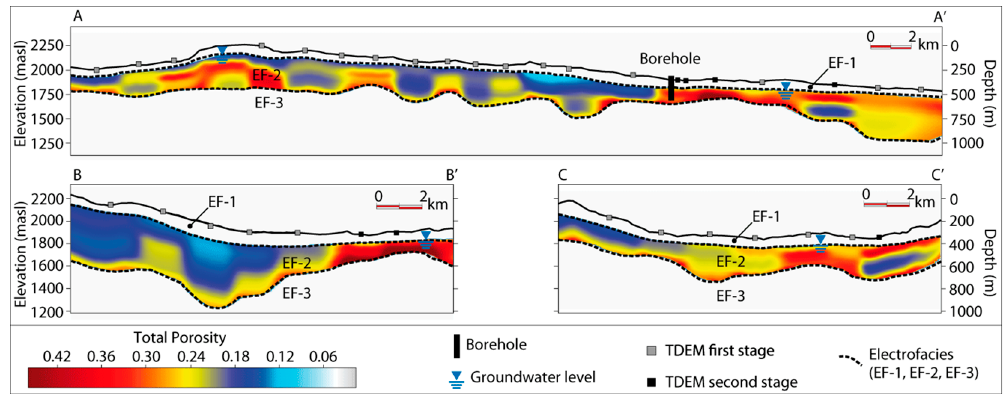
Figure 6. Subsurface porosity model. EF: electrofacies. AA ′ , BB ′ and CC ′ refer to geophysical cross ‐ sections shown in Figure 2.